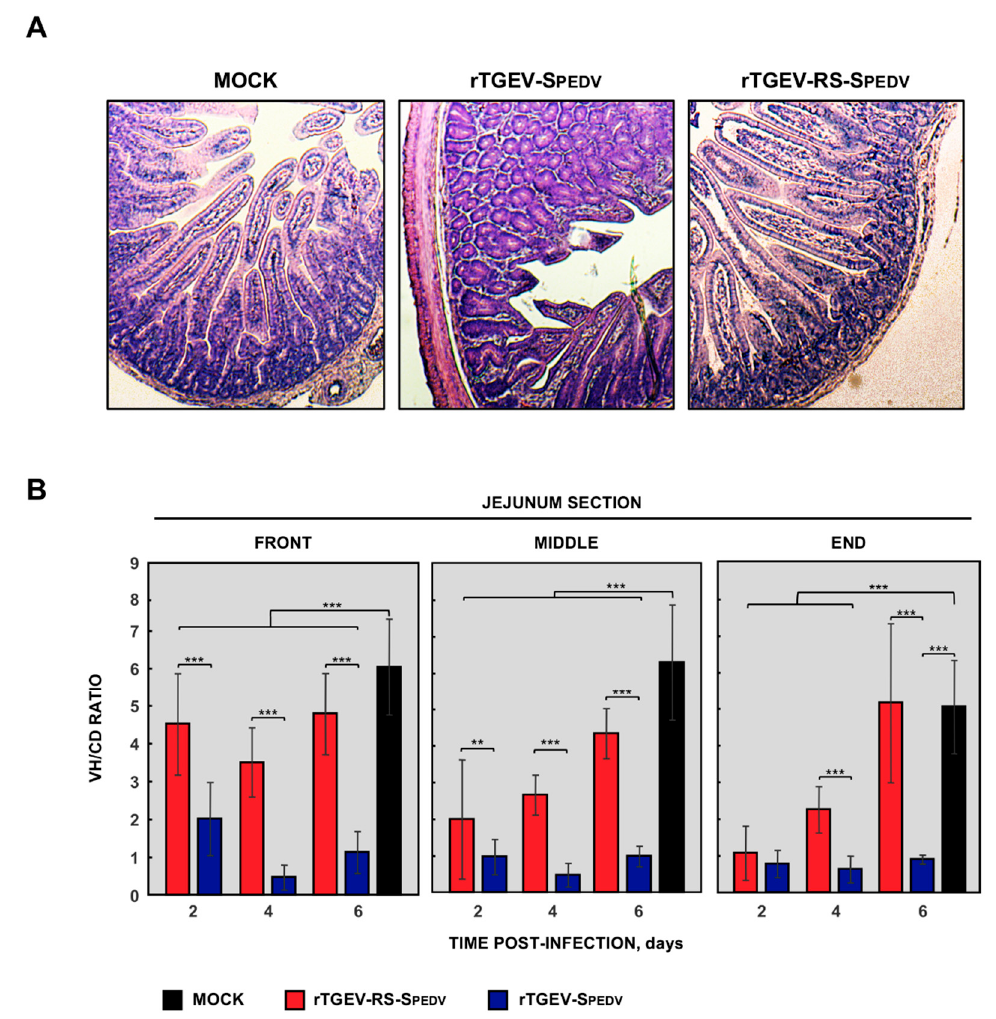
Figure 4. Intestinal damage in suckling piglets infected with rTGEV-SPEDV viruses. ( A ) Representative hematoxylin-eosin-stained front sections from non-infected animals (mock), or animals infected with rTGEV-SPEDV or rTGEV-RS-SPEDV viruses, at six days post-infection. Pictures were obtained with a 2.5 × objective. ( B ) Villous height to crypt depth (VH / CD) ratio in front, middle, and end sections at different days post-infection. Non-infected animals (black), or animals infected with rTGEV-SPEDV (blue) or rTGEV-RS-SPEDV (red) viruses. Represented values are the mean from three independent animals, two fields per section. Error bars represent the standard deviation for each value; p values, ** < 0.01, *** < 0.001.